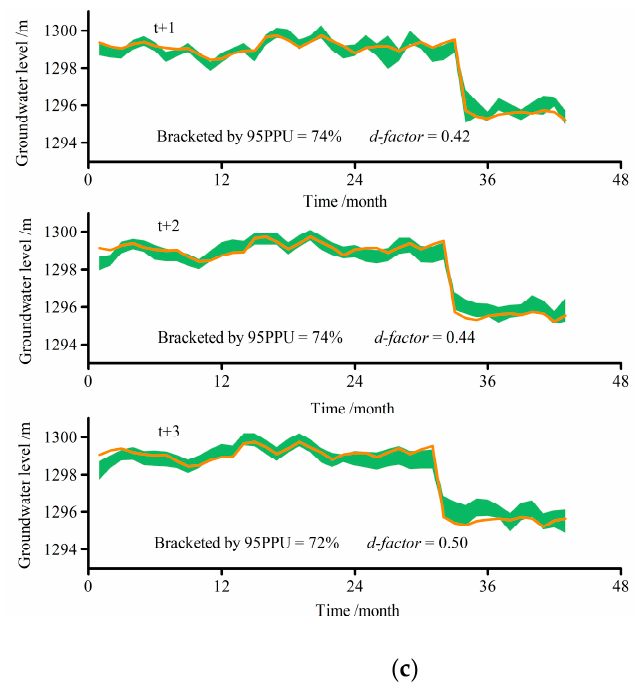
Figure 9. Observed groundwater level and the 95% confidence intervals forecasted by VBELM model with randomly sampled input vectors for 1, 2 and 3-months ahead forest during the testing period at Well I ( a ), Well II ( b ) and Well III ( c ).